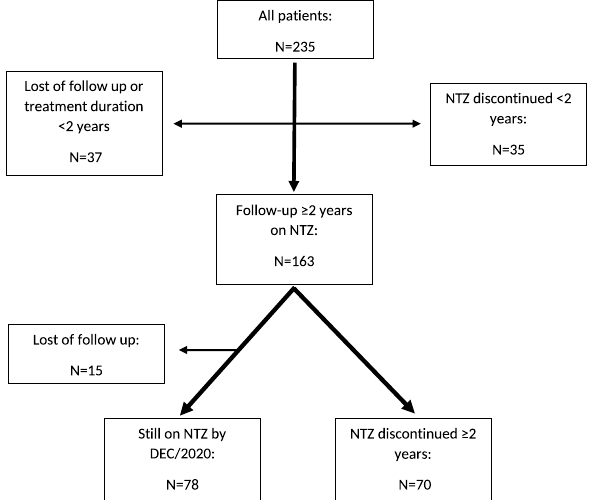
Figure 1. Cohort of patients treated with NTZ, flow chart. Flow chart of all MS patients at the University hospital of Innsbruck, Austria, treated with NTZ from 2006 to 2020. All these selected patients (N = 235) were eligible for the pre-treatment analysis. For the on-treatment analysis patients with a minimum treatment duration of 2 years were considered (N = 163) by excluding those patients who were lost of follow-up or discontinued NTZ within less than 2 years or were still on NTZ by DEC/2020 but with a treatment duration less than 2 years. The discontinuation analysis was performed on all patients who discontinued NTZ before or after a treatment duration of 2 years (N =